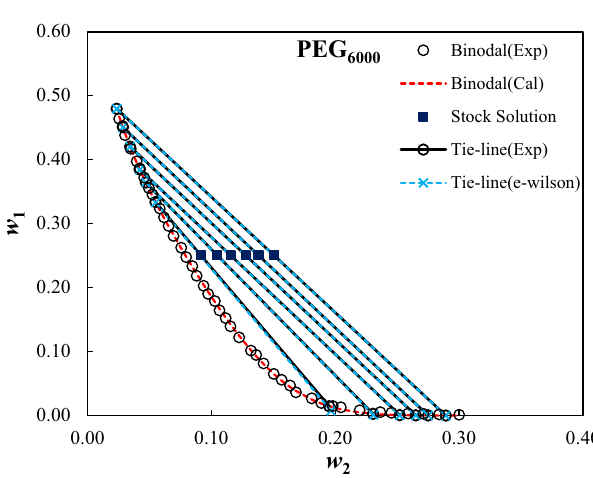
Figures 8. Like Fig. 5 for PEG 6000 (1) + trilithium citrate (2) + water (3)